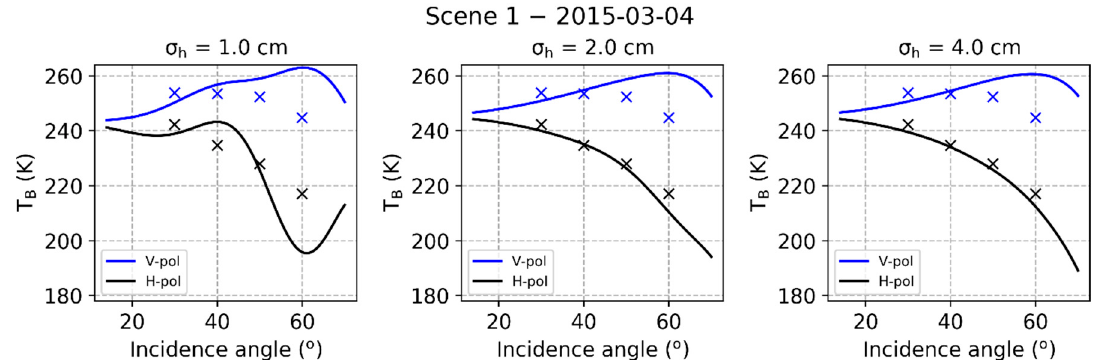
Figure 4. T B V-pol (blue) and T B H-pol (black) for 4 March 2015 at Scene 1 measured (symbols) and simulated (lines) with WALOMIS with added Gaussian noise ( σ h ) to the measured layer thickness of 1 cm ( left ), 2 cm ( center ) and 4 cm ( right ).